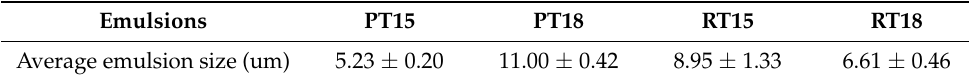
Table 3. Average droplet size for PT15, PT18, RT15, and RT18 water emulsions. Figure 3. DSC thermogram of ( a ) PT15 ( b ) PT18 ( c ) RT15, ( d ) RT18 in water emulsions in their 1st thermal cycle. Obtained melting/solidification temperatures and enthalpies are shown.